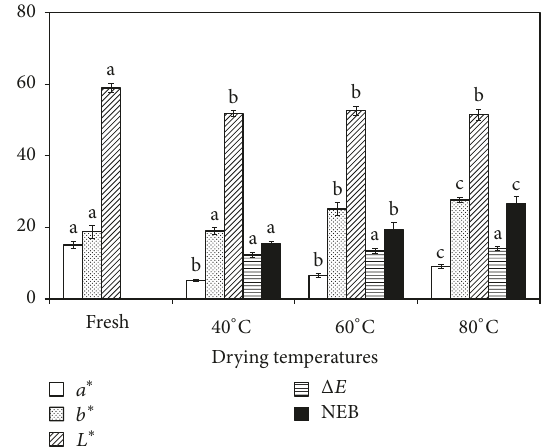
Figure 3: Effect of drying temperature on color differences ( Δ𝐸 ), chromaticity coordinates 𝐿 ∗ , 𝑎 ∗ , and 𝑏 ∗ (whiteness or brightness, redness/greenness, and yellowness/blueness), and nonenzymatic browning (NEB × 10 −2 ) of fresh and rehydrated abalone. Different letters above the bars indicate significant differences ( 𝑝 < 0.05